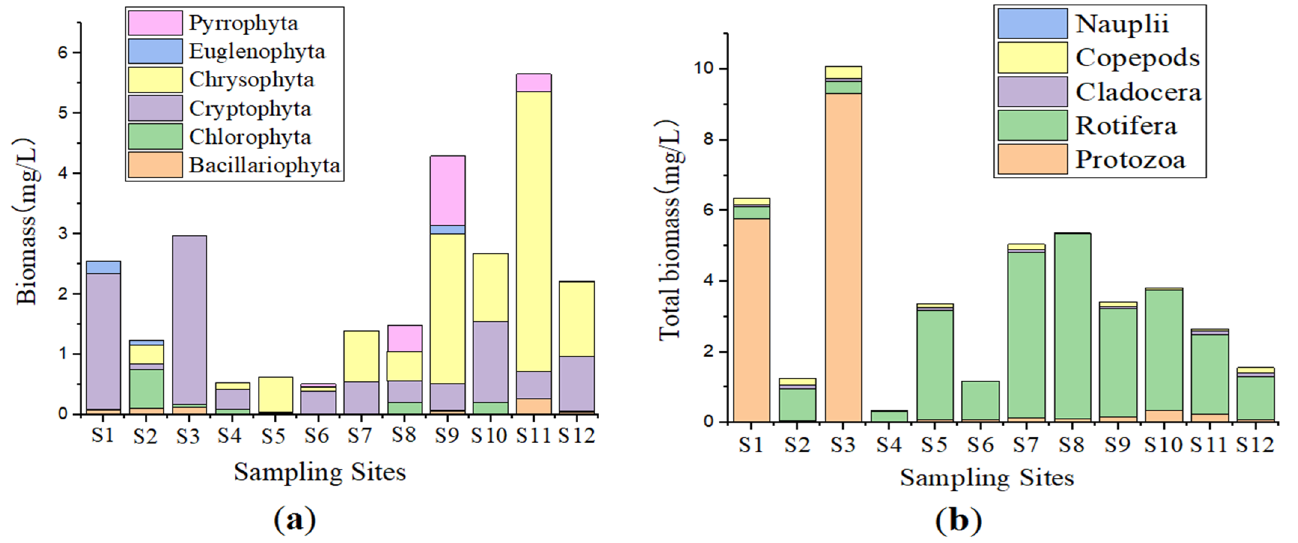
Figure 3. Biomass of plankton community in the sampling points. Total biomass of ( a ) phytoplankton, ( b ) Zooplankton.